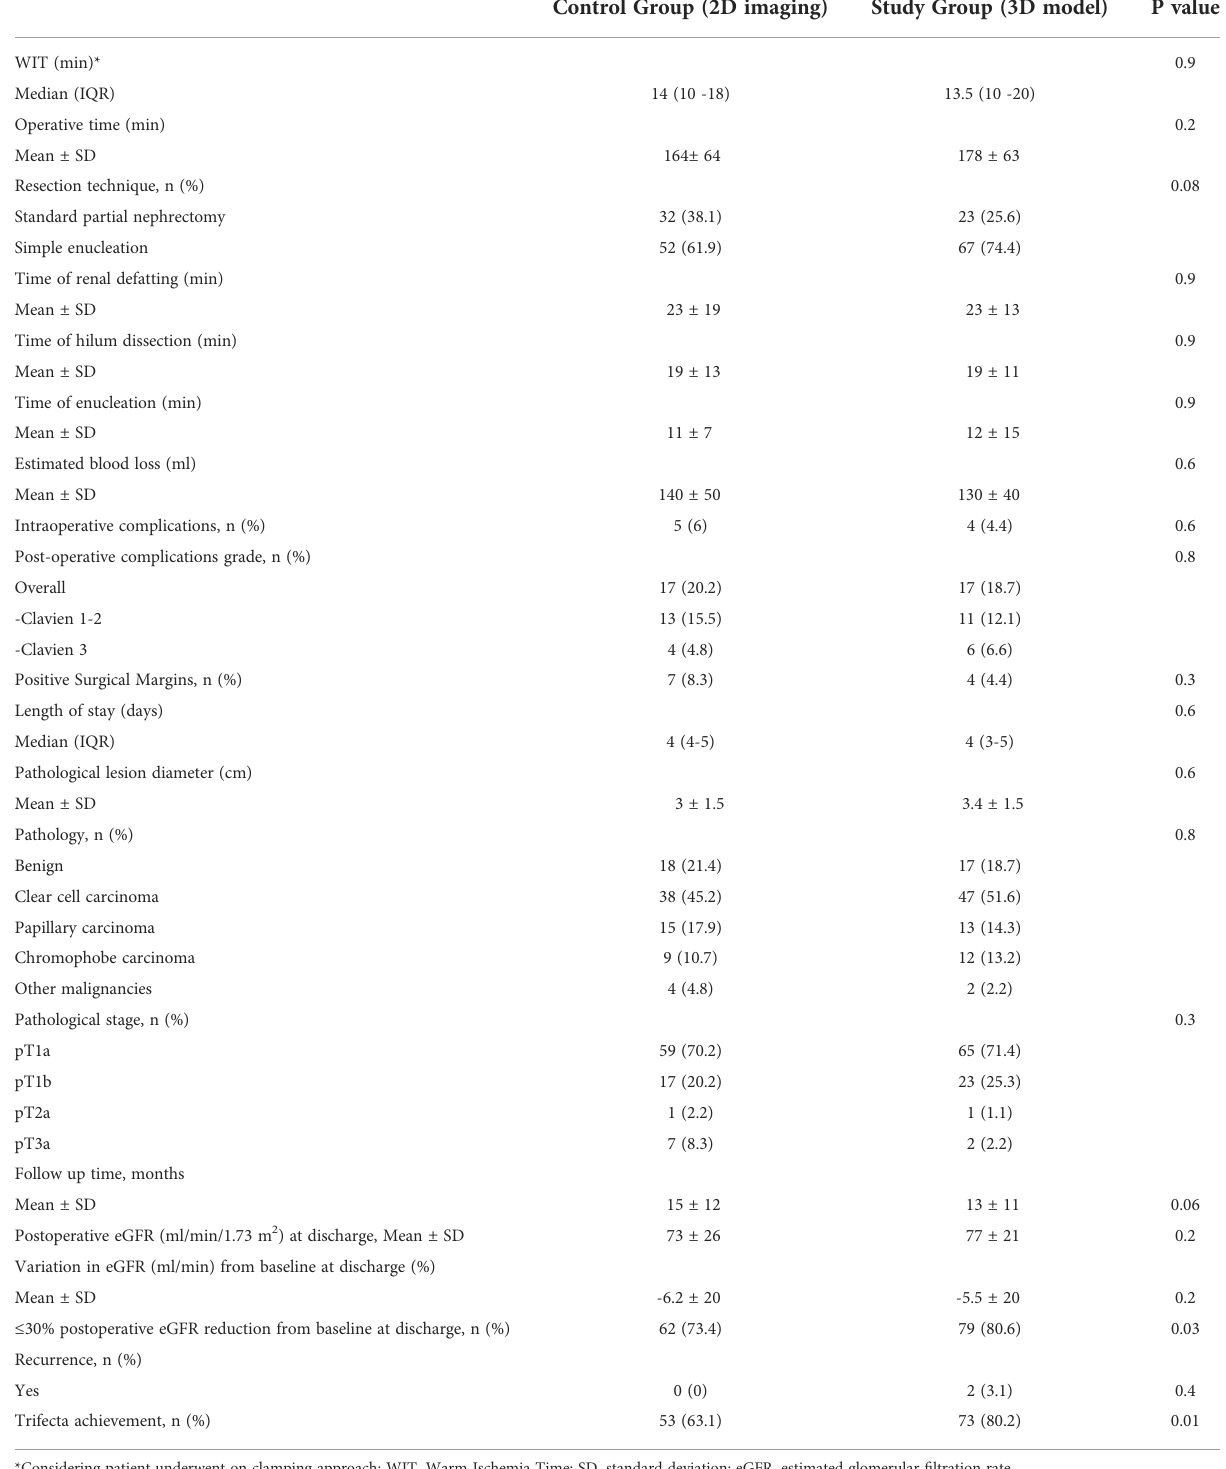
TABLE 3 Intraoperative, peri-operative, pathologic and postoperative characteristics in the overall population underwent PN